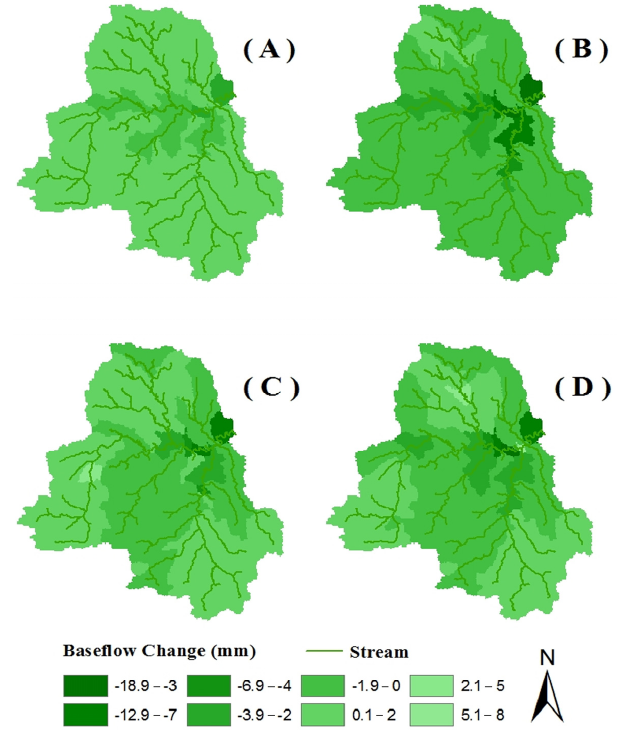
Figure 5. Changes in baseflow from 1970s to 2000s calculated for spring ( A ); summer ( B ); autumn ( C ); and winter ( D ) seasons.